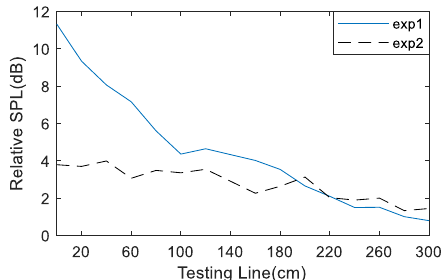
Figure 9. Comparison diagram of relative SPL distribution. “exp1” shows the non-optimized relative SPL distribution. “exp2” shows the optimized relative SPL